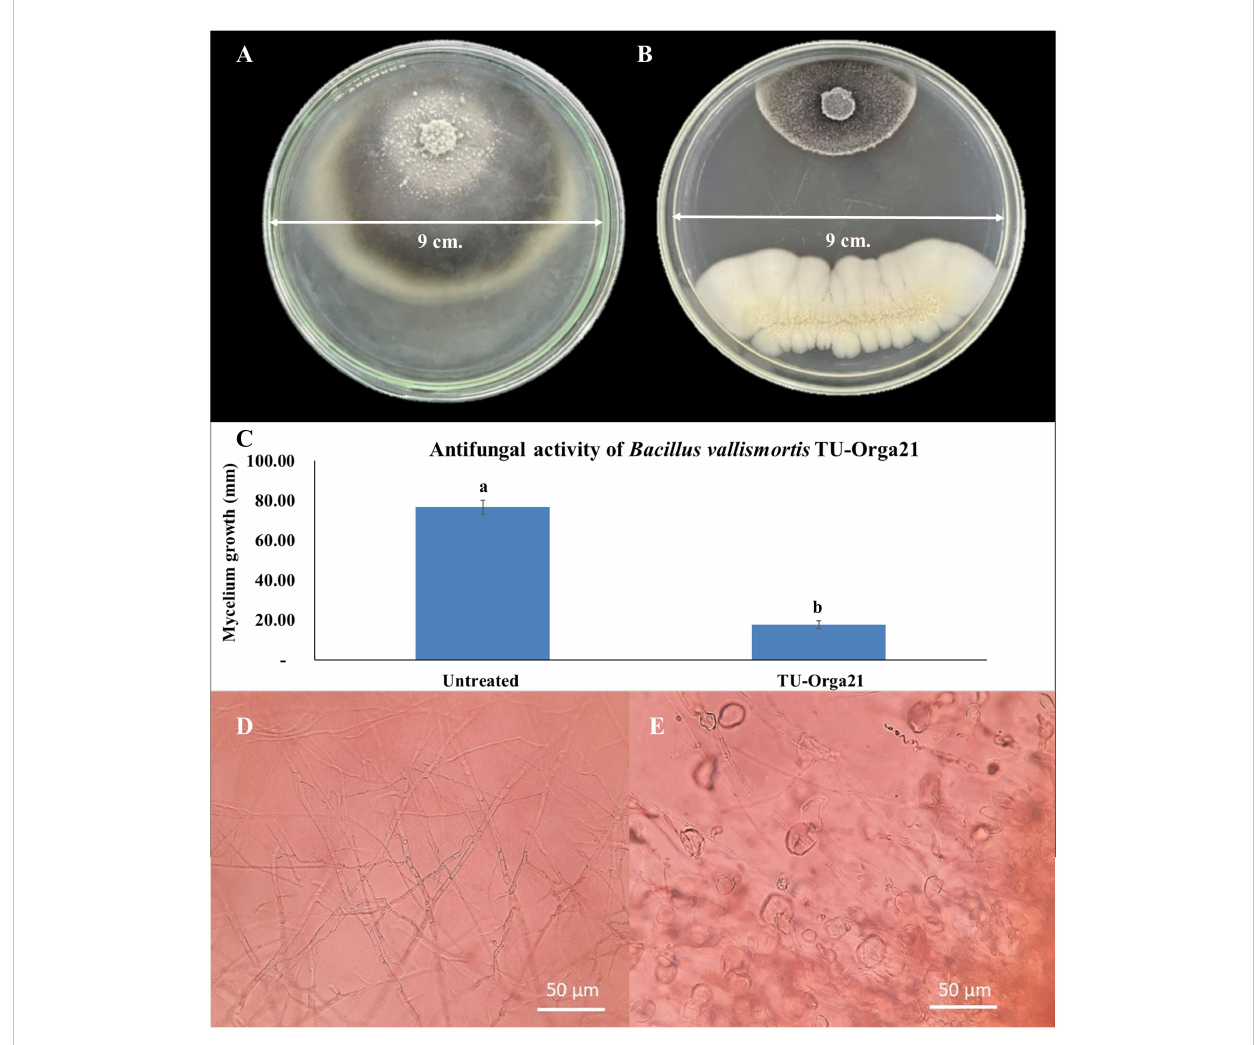
FIGURE 2 Observations of the antagonist testing against Magnaporthe oryzae . (A) M. oryzae mycelium growth in an untreated control plate. (B) Inhibition by Bacillus vallismortis . (C) M. oryzae mycelium growth bar plot in an untreated control plate compared with that in a B vallismortis – treated plate (D) Normal hyphae of M. oryzae in an untreated control plate. (E) Damaged hyphae of M. oryzae in a B vallismortis – treated plate. Means in the graph followed by different letters are signi fi cantly different according to DMRT at p =